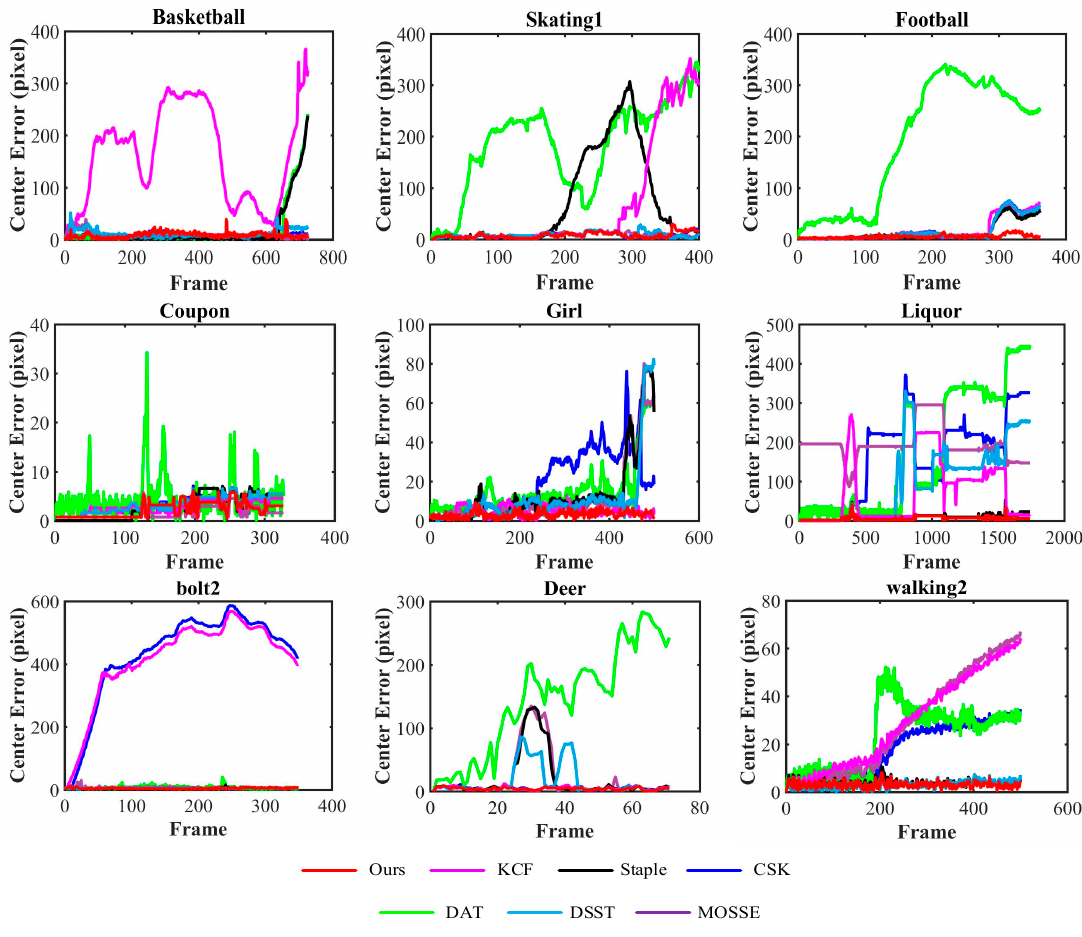
Figure 3. Frame-by-frame comparison of 7 trackers on 9 video sequences in terms of average center location errors (in pixels) in descending order. The horizontal axis represents the frame number, and the vertical axis represents the center location error. The smaller is the center location error, the better is the tracking accuracy.